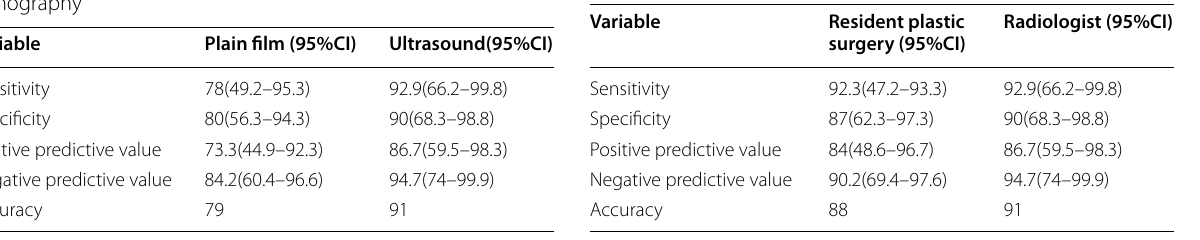
Table 2 Sensitivity and specificity compared to computer Table 3 Performance between